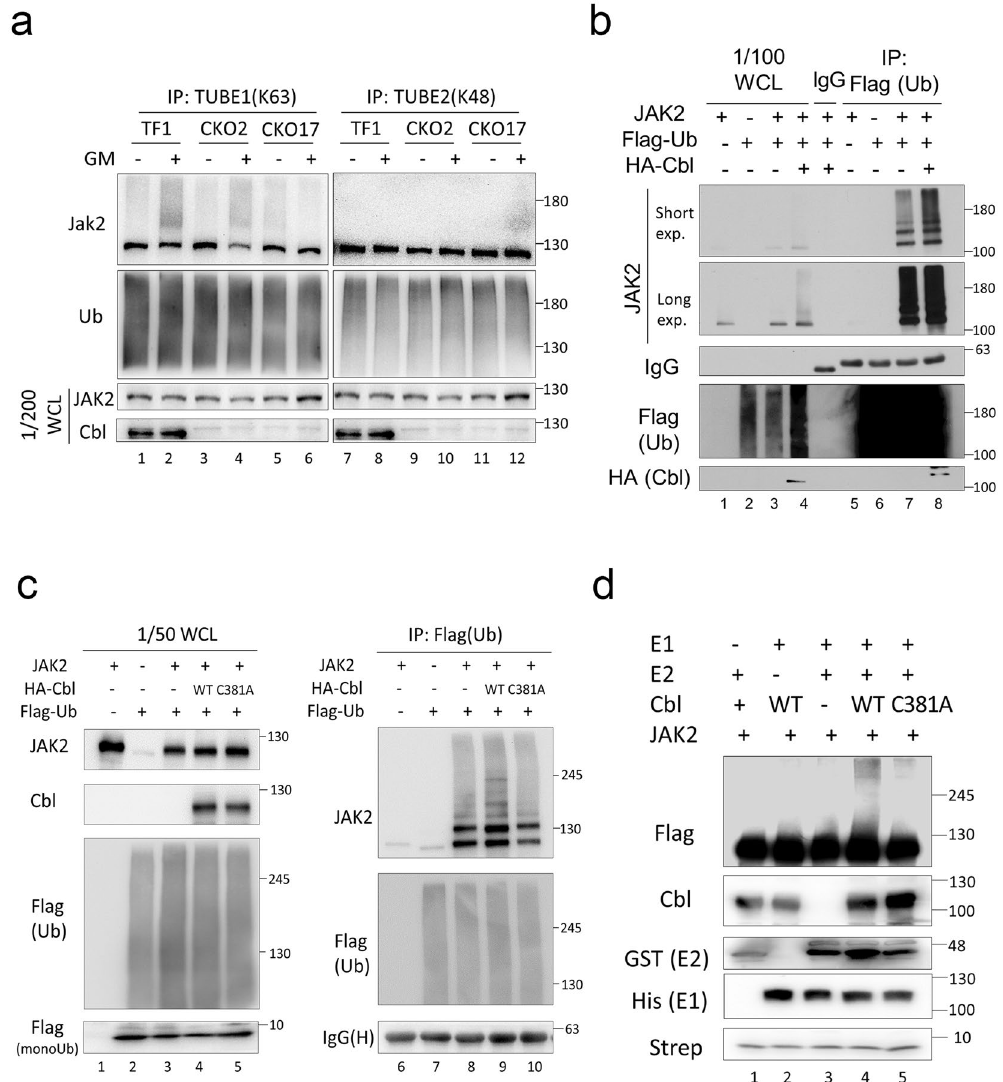
Figure 2. Cbl directly ubiquitinates JAK2 via the K63 linkage. ( a ) Cbl is involved in cytokine-triggered K63- linked ubiquitination of JAK2. After overnight serum starvation, parental TF1 cells (TF1) or Cbl knockout TF1 cells (CKO2 and CKO17) were processed and analysed as described in Fig. 1b. ( b ) Ectopic expression of Cbl enhances JAK2 ubiquitination. JAK2 and Flag-tagged ubiquitin were co-expressed in 293 T cells with or without HA-Cbl as described previously. WCL were prepared and analysed as described in Fig. 1c. A short and longer exposure of the JAK2 Western blot is shown for clarity. ( c ) Cbl rescues high molecular weight signals of JAK2 ubiquitination. JAK2 and Flag-tagged ubiquitin were co-expressed in Cbl knockout GMR HeLa (CKO) cells with or without HA-Cbl (wide type or C381A, a ligase-deficient mutant), then subjected to analysis as described in Fig. 1c. ( d ) JAK2 is directly ubiquitinated by Cbl in an in vitro assay. For the in vitro ubiquitination assay, Flag-tagged JAK2 and HA-tagged WT or C381A mutant Cbl were prepared as described in the Methods, and these were then incubated with recombinant E1, E2 (Ubc13), or both together, in the presence of biotin-labelled ubiquitin. After incubation, reactions were directly analysed by western blot with the indicated